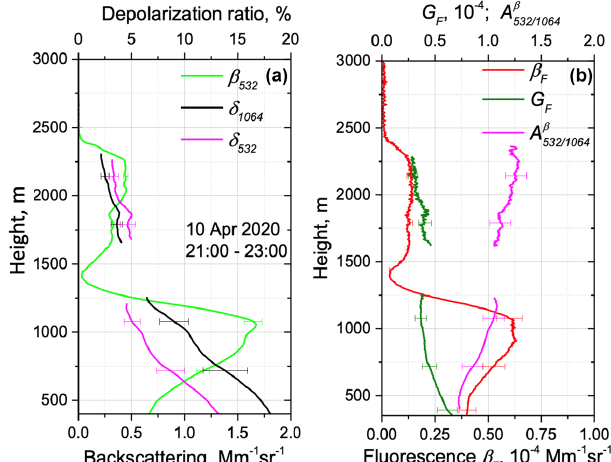
Figure 13. Vertical profiles of the (a) backscattering coefficient β 532 and particle depolarization ratios δ 532 and δ 1064 . (b) Fluores- cence backscattering β F , fluorescence capacity G F , and backscat- tering Ångström exponent A β on 10 April 2020 for the pe- 532 / 1064 riod